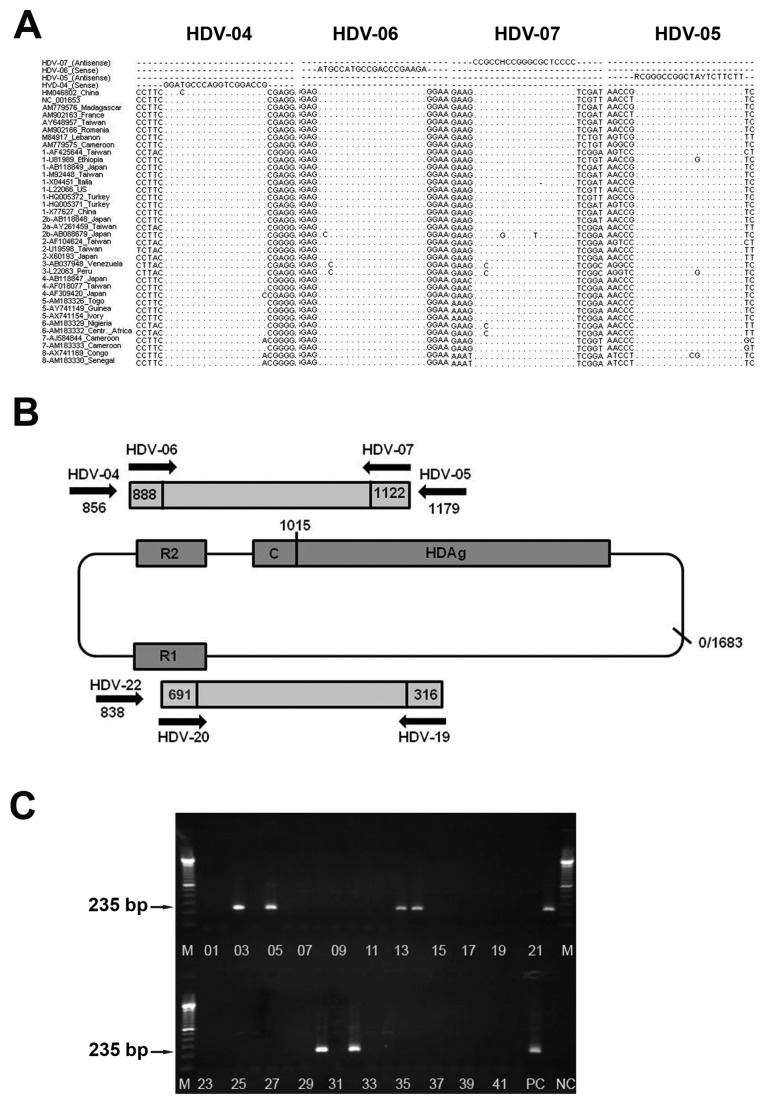
Strategy of primer design and RT-PCR schema.(A) Primer design for HDV-specific nested RT-PCR located in a highly conserved region of the HDV genome. HDV-specific primers HDV-04 and HDV-05 for the first PCR round, HDV-06 and HDV-07 for the nested PCR were designed for HDV detection and genotyping. The primers were matched and aligned with 38 reference sequences of the eight HDV genotypes available in the NCBI-GenBank. The primer sequences target to the ribozyme and HDAg domains of the HDV genome. The numbers 1 to 8 of each reference sequence code for the respective HDV-genotype. R1, R2 = ribozyme domain; C = C-terminal amino acid extension. HDAg: Hepatitis Delta antigen; position marked at nt 1015 indicates RNA editing site. (B) Schematic representation of primer binding sites. The primers HDV-06 and HDV-07 of the nested PCR used for HDV detection and HDV-genotyping span the region from nt 888 to nt 1122. The HDV-fragment from the position nt 316 to nt 691 is generated by the primer pair HDV-19 and HDV-20. Numbering is according to HDV strain NC1001653. (C) Representative example of 1.5% agarose gelelectrophoresis of amplified HDV products. HDV specific nRT-PCR amplicons of 235 bp are shown. HDV positive samples could be identified in lanes 3, 5, 13, 14, 22, 30, and 32. Positive control (PC) was a HDV full-length plasmid. NC = negative control. Marker (M) is 100bp DNA ladder.